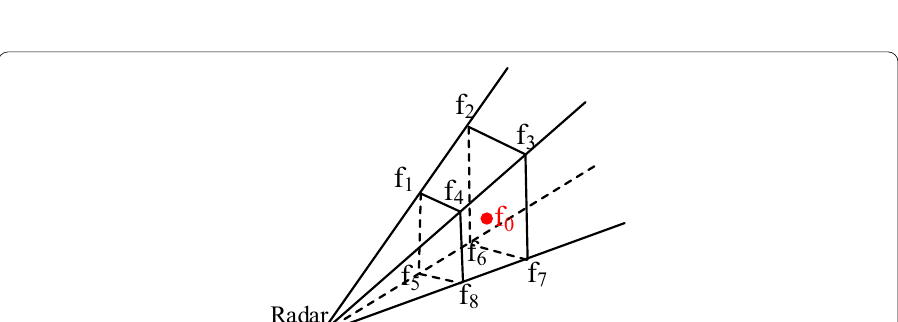
Fig. 1 The schematic diagram of PPI scan mode